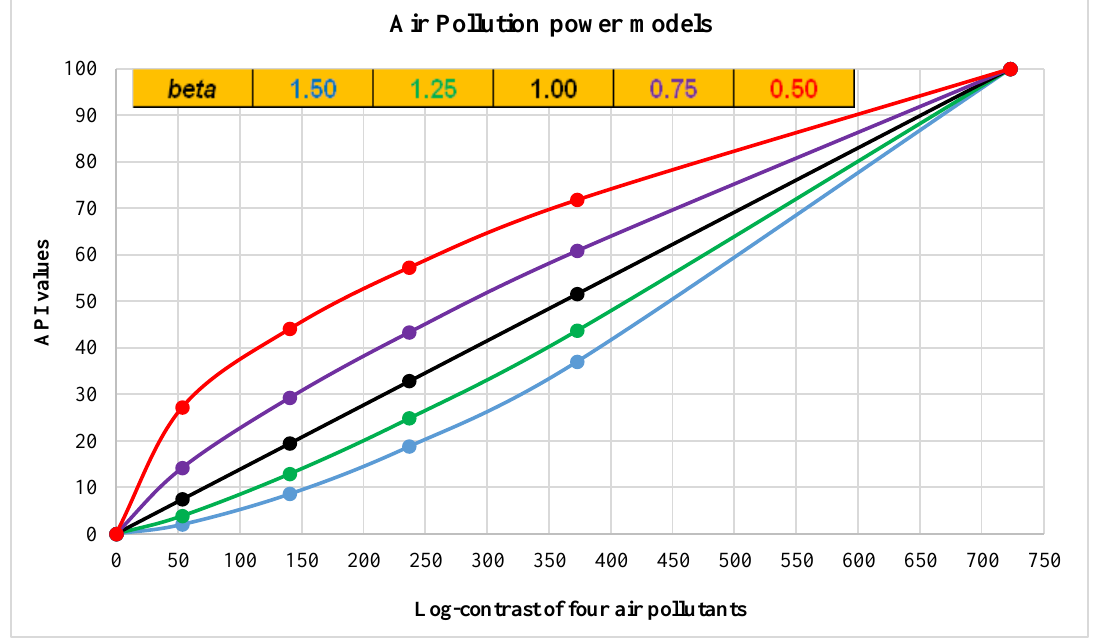
Figure 2. Different Air Pollution power models, computed from a log-contrast of four air pollutants. (API-1, power = 1.50; API-2, power = 1.25; API-3, power = 1.00 (linear model); API-4, power = 0.75 and API-5, power = 0.50). The multiplicative factor K is introduced for ranging air pollution index values in a scale from zero to 100. The global value of the multiplicative factor K depends on the value of β exponent, as well as on the maximum pollutant’ global concentrations adopted as maximum admissible pollution [14, 17]. An example is shown in Table 1 and the corresponding value of K is global